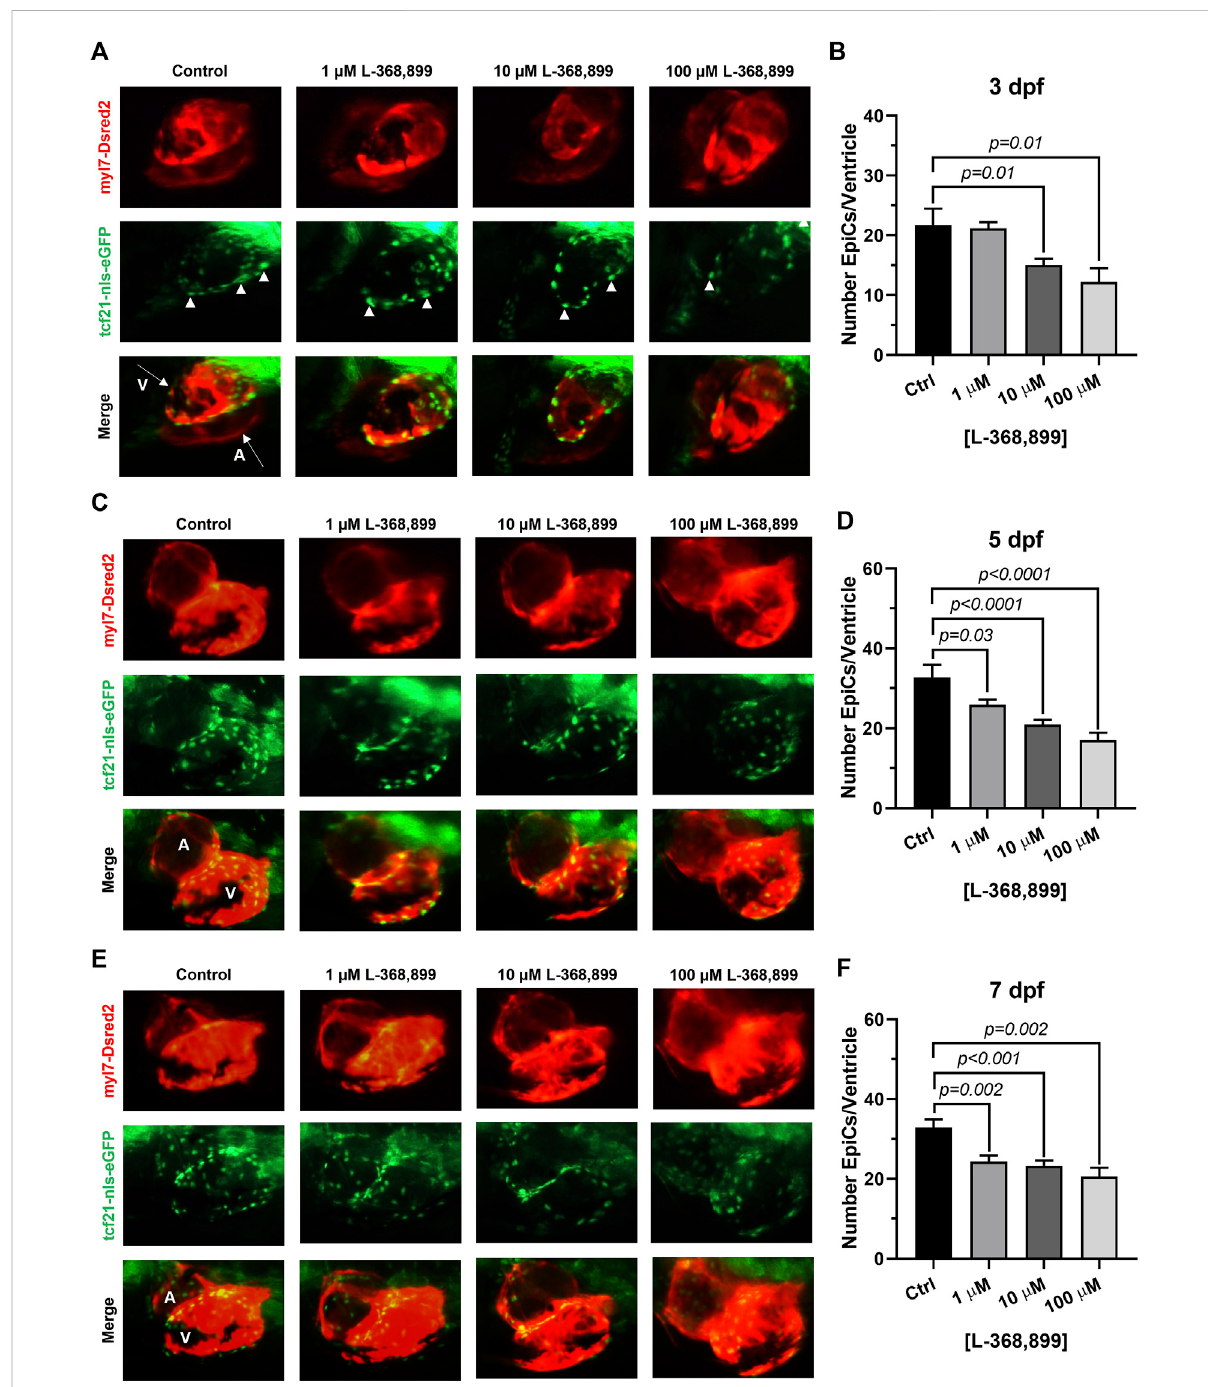
FIGURE 5 Oxytocin Signaling is Necessary for Epicardium Development in Zebra fi sh. (A – F) Fluorescent images (A,C,E) and epicardial cell counts per ventricle (B,D,F) ofdevelopingzebra fi shembryosat3,5,and7dpftreatedwithdifferentconcentrationsofL-368,899.In (A)(C) ,and (E) proepicardial and epicardial cell nuclei are labeled with GFP (tcf21-nls-eGFP, arrowheads), myocardium is labeled with DsRed2 (red); n ≥ 5 embryos per condition for each time point; (A) Atrium, dpf: Days Post-Fertilization, V: Ventricle.